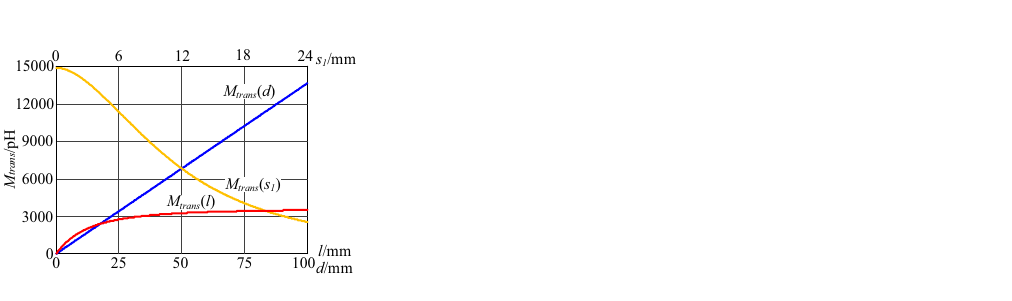
Figure 12. Mutual inductance between each transformer winding and plug loop.